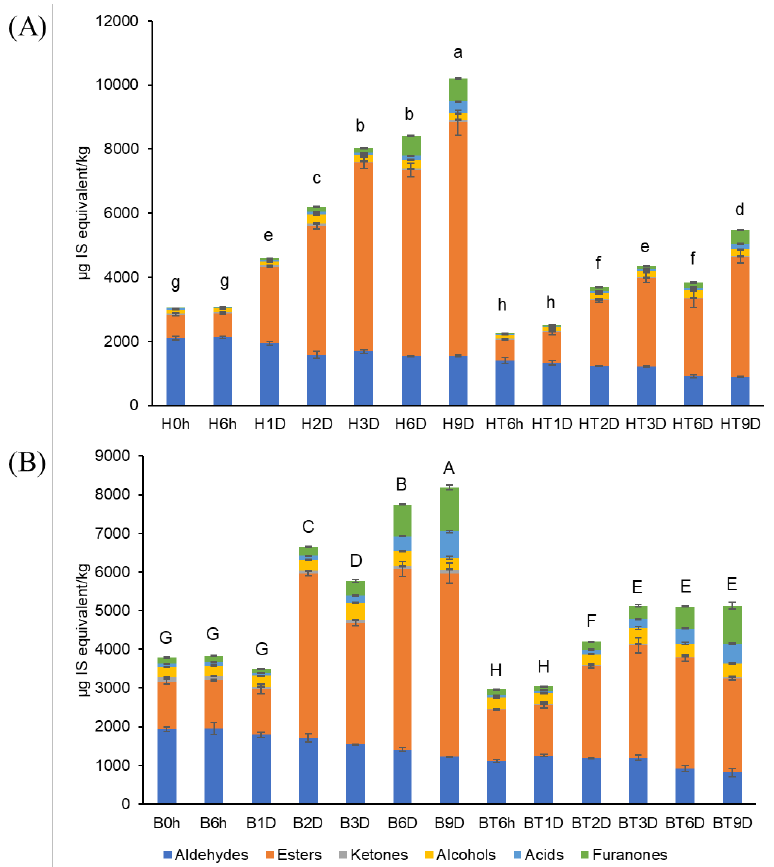
Figure 2. Sum of volatile compounds in ( A ) half-red and ( B ) bright-red strawberries stored at 10 °C for 9 d (H: half-red, B: bright-red, T: CO 2 -treated, h: hours, D: days). Lowercase and capital letters indicate significant difference for half-red and bright-red strawberries, respectively ( p < 0.05). The volatile composition of strawberries varied with maturity. For example, bright-red strawberries showed a higher ester/aldehyde ratio compared to that of half-red strawber- ries at day 0. After 9 d of storage, the aldehyde contents of half-red strawberries (H9D) and bright-red strawberries (B9D) decreased to 78% and 71%, respectively, compared to that at day 0. However, the ester contents of H9D and B9D increased 3.0-fold and 1.8-fold, respec- tively, compared to that at day 0. The ester content of CO 2 -treated half-red strawberries (HT9D) was 68.5% that of the total volatiles. This value was similar to that of the